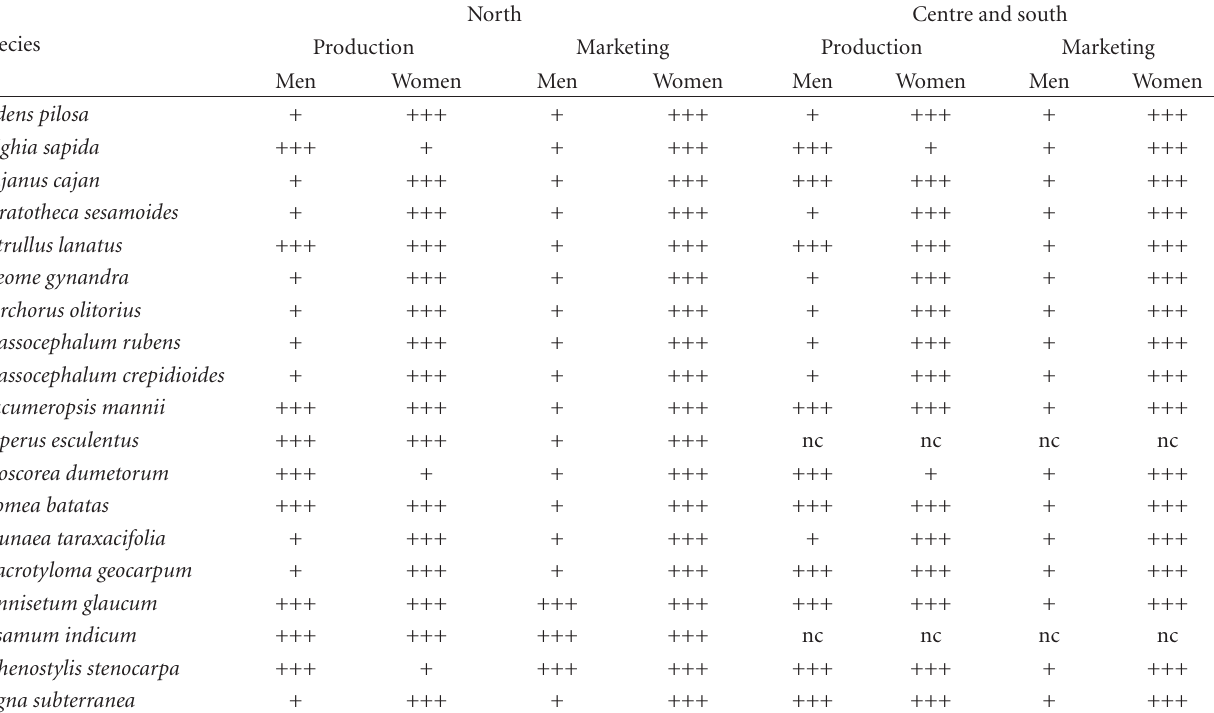
Table 7: Contribution of both men and women to the production and marketing of the priority neglected and underutilized crops species in